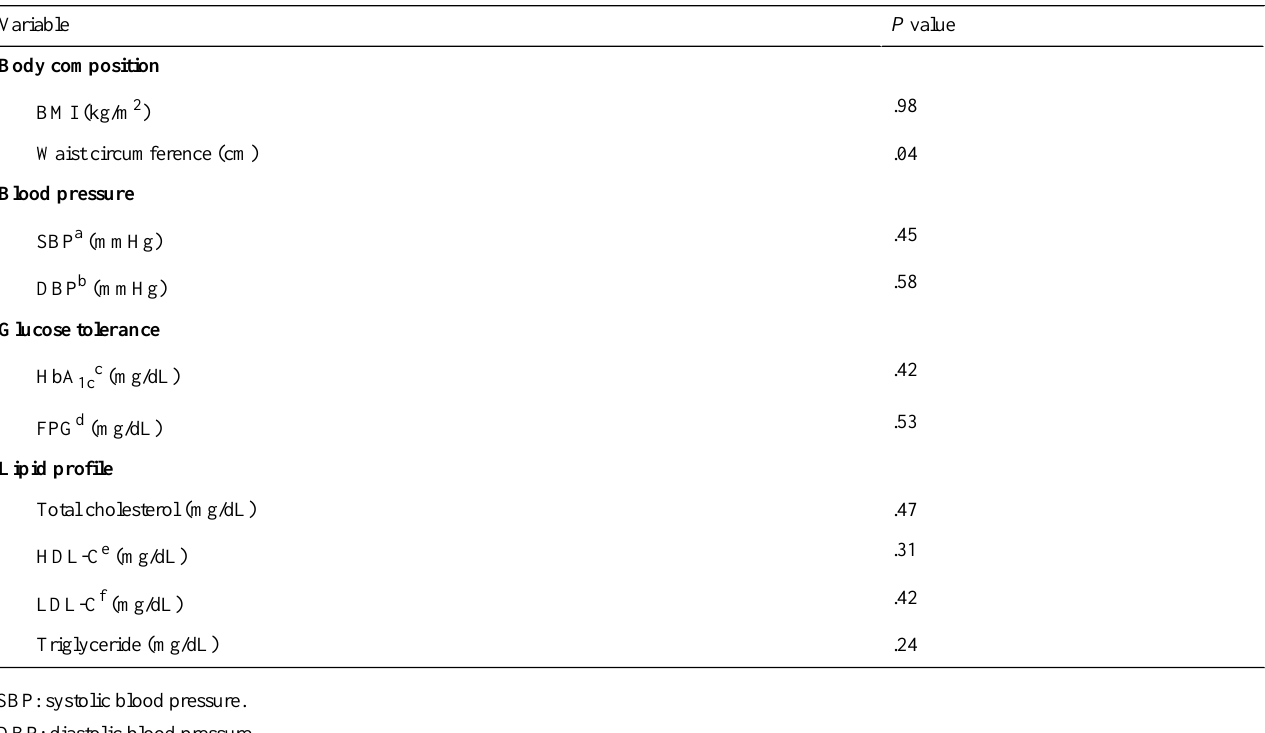
Table 5. Egger test